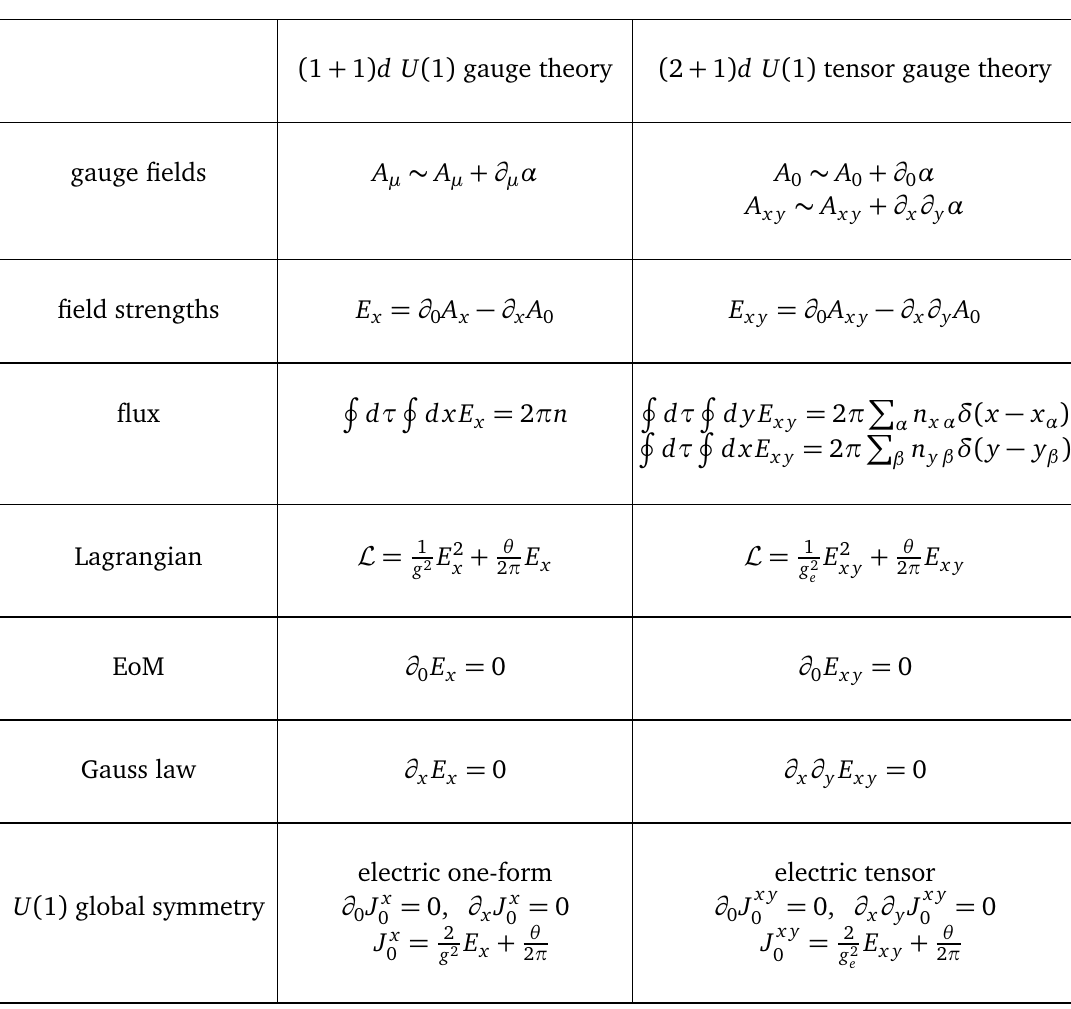
Table 3: Analogy between the 1 + 1-dimensional U ( 1 ) gauge theory and the 2 + 1- dimensional U ( 1 ) tensor gauge theory. Detailed explanations will be given in the body of the